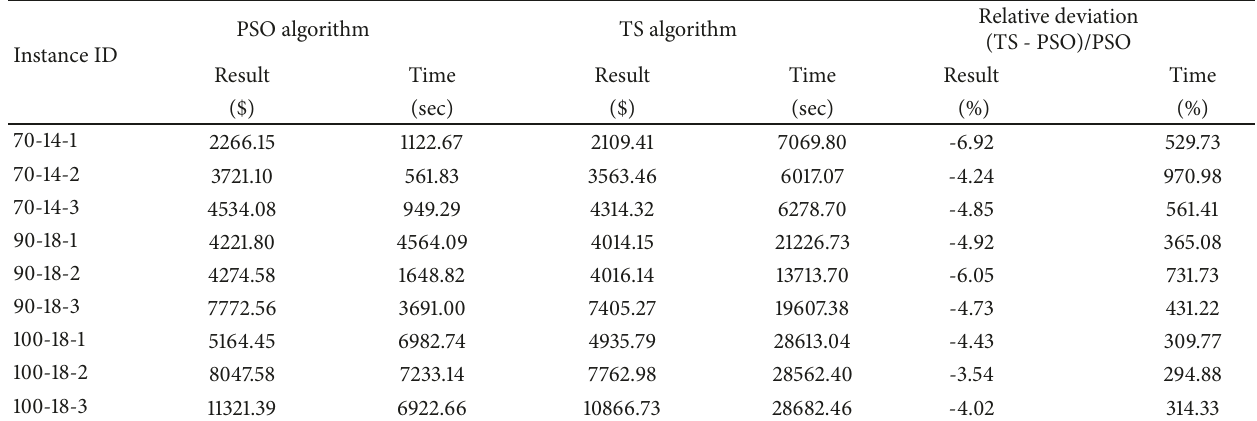
Table 4: Computational results of large-scale